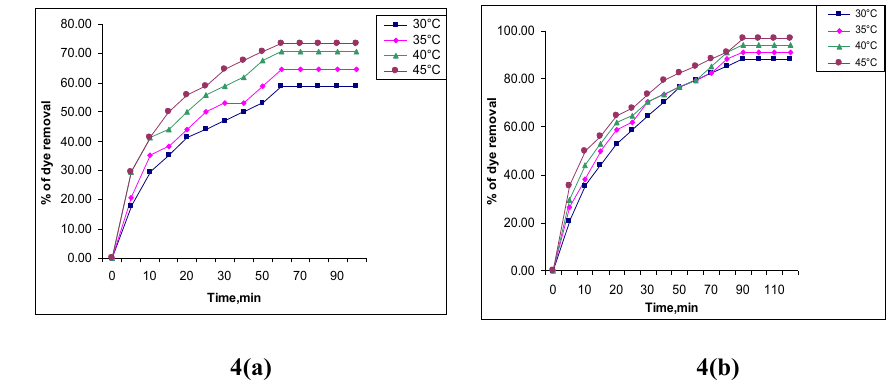
Figure 3. Effect of agitation time on the percentage removal of DB 71 dye on TPAC and PPC at 30°C (adsorbent dosage, 100mg; pH, 4.3; initial dye concentration, 50 mg/L).